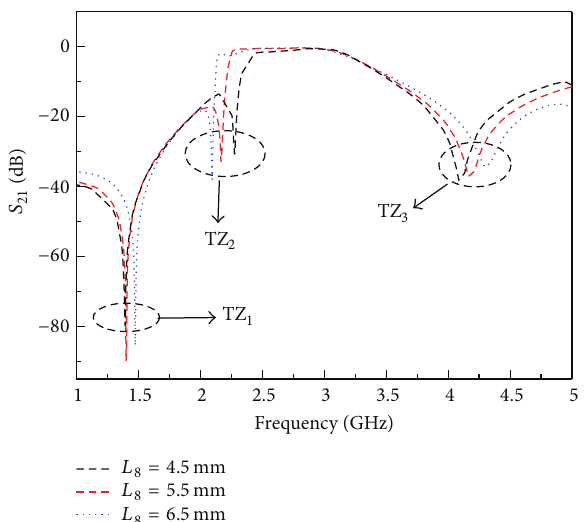
Figure 6: Transmission characteristics of the filter versus 𝐿 8 .